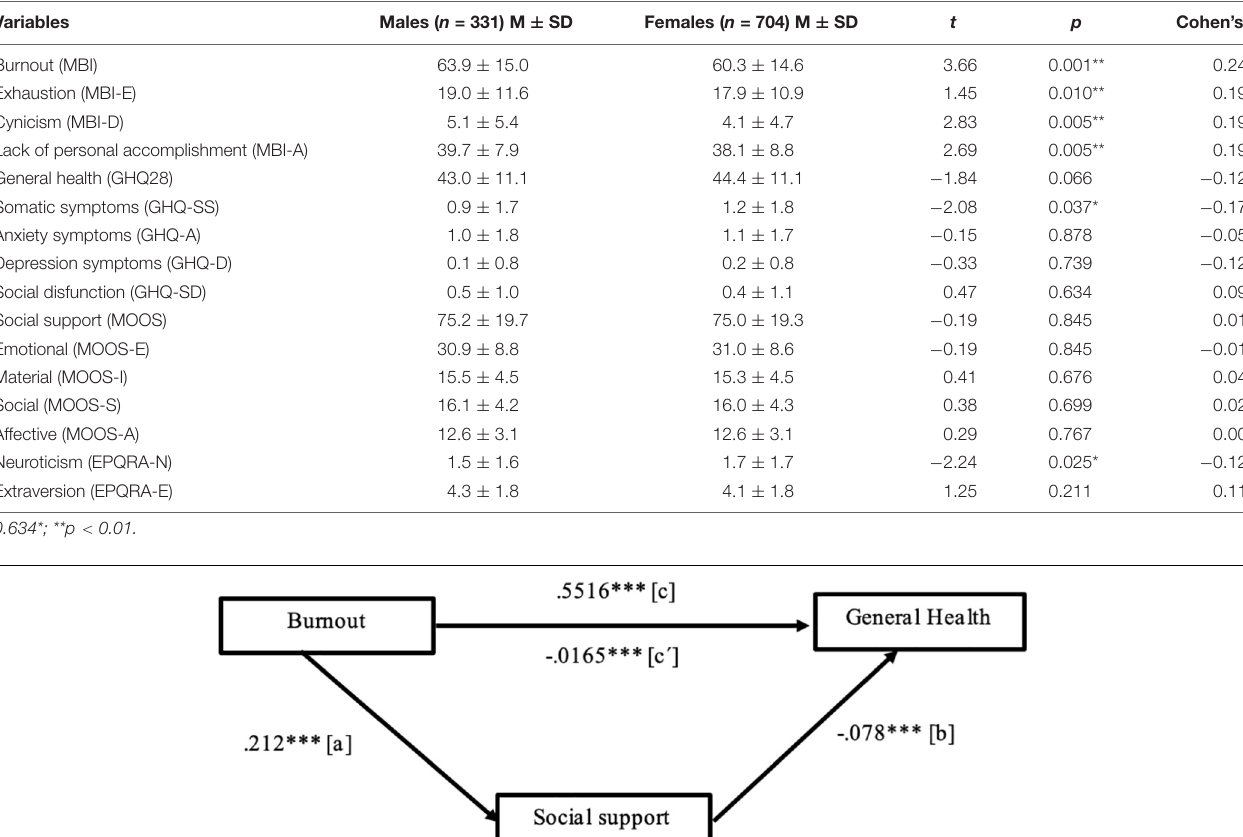
TABLE 2 | Gender differences in outcome variables.